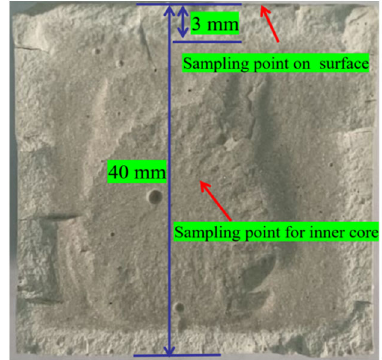
Figure 3. Measurement of the water erosion depth and sampling